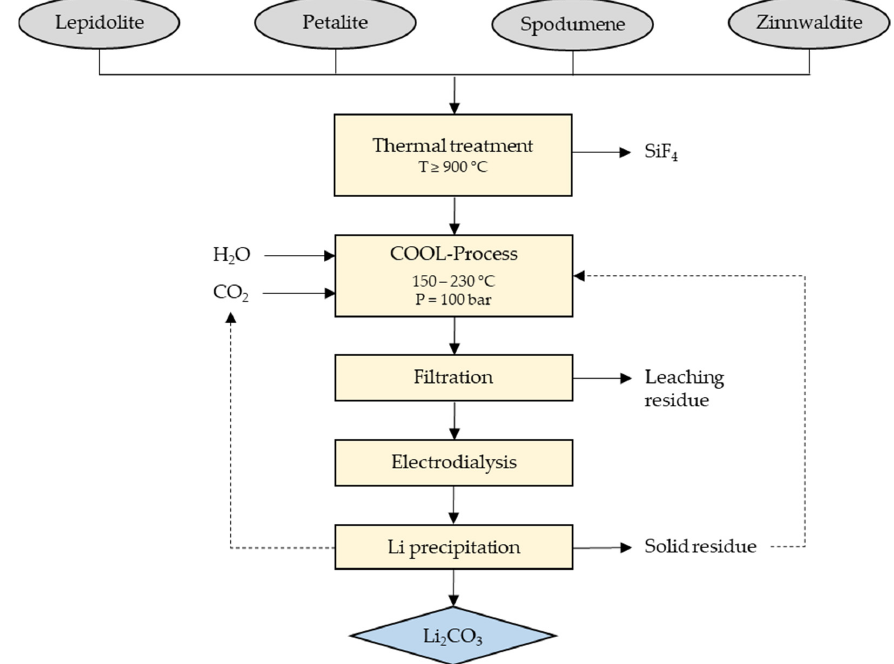
Figure 1. Flowsheet for the production of Li 2 CO 3 from Lepidolite, Petalite, Spodumene, and Zinnwaldite minerals by direct carbonation [21].